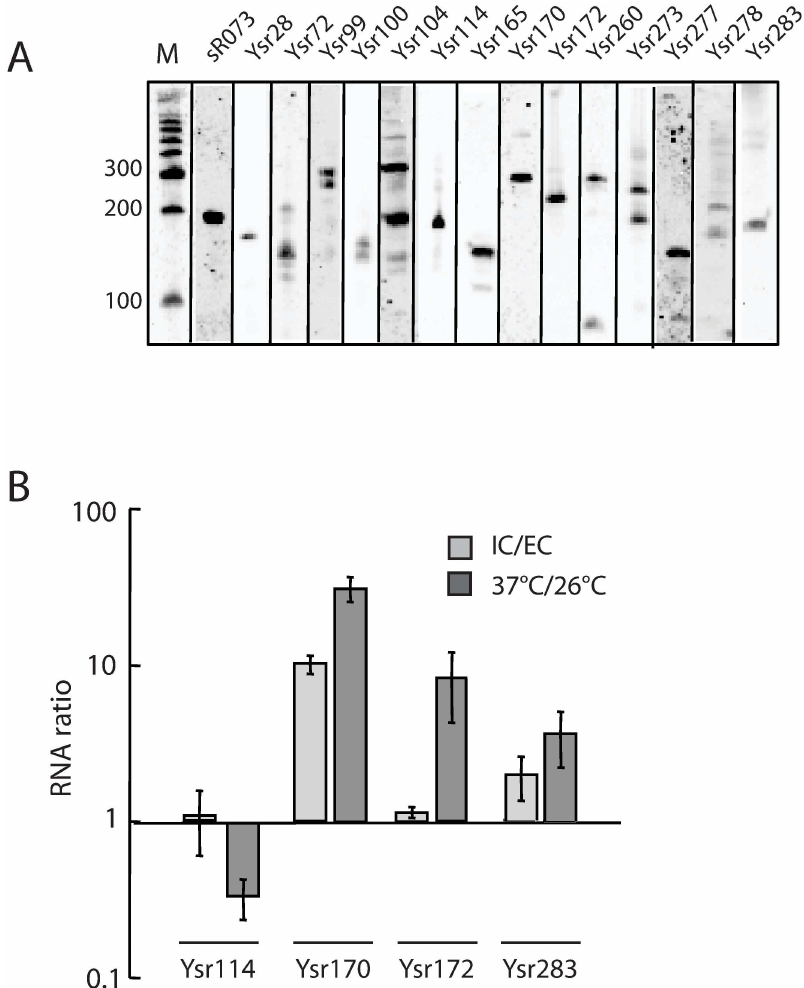
Fig 2. Validation of candidate sRNA gene expression. (A) sRNA expression was analyzedby northernblot. Total Y . pestis RNA was separatedon a 6% denaturing polyacrylamide gel,transferredto a nylonmembrane, and probedwith biotinylatedoligosto target specificsRNAs. The size of the transcripts was determined by using a polyA-tailedRNA ladder.(B) RT-PCRanalysiswas performedon total RNA isolatedfrom Y . pestis in the intracellular(IC) or extracellular (EC) fraction after infectionof THP-1 cells or grownat 37˚ or 26˚C. The relative sRNA levelsare presentedas fold expressionbetweeneitherintracellular and extracellular fractions or the two temperature conditions. For each sample,the sRNA levelswerenormalizedto 5S rRNA. The averagemean and standard deviationfrom threerepresentative experiments are shown.